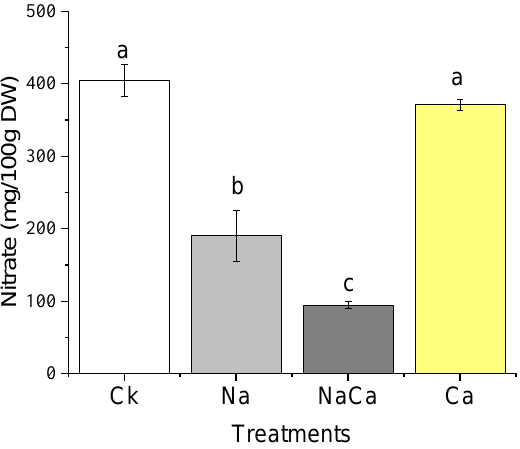
Figure 2. Sulforaphane content of broccoli microgreens under different treatments. CK, distilled water; Na, 80 mmol/L NaCl; NaCa, 80 mmol/L NaCl + 1.39 mmol/L CaSO 4 ; Ca, 1.39 mmol/L CaSO 4 ; DW, dry weight. Data are expressed as the mean ± standard deviation (SD), values labelled with different letters are significantly different ( p < 0.05).